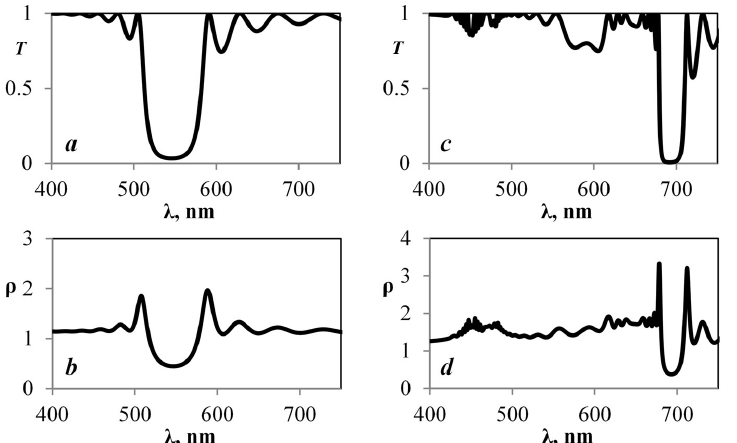
Figure 4. Graphs for the periodic structure obtained using the Cantor method. Period increased by 10%. ( a ) Transmission spectrum excluding dispersion. ( b ) Graph of the density of photon states excluding dispersion. ( c ) Transmission spectrum including dispersion. ( d ) Graph of the density of photon states including dispersion.